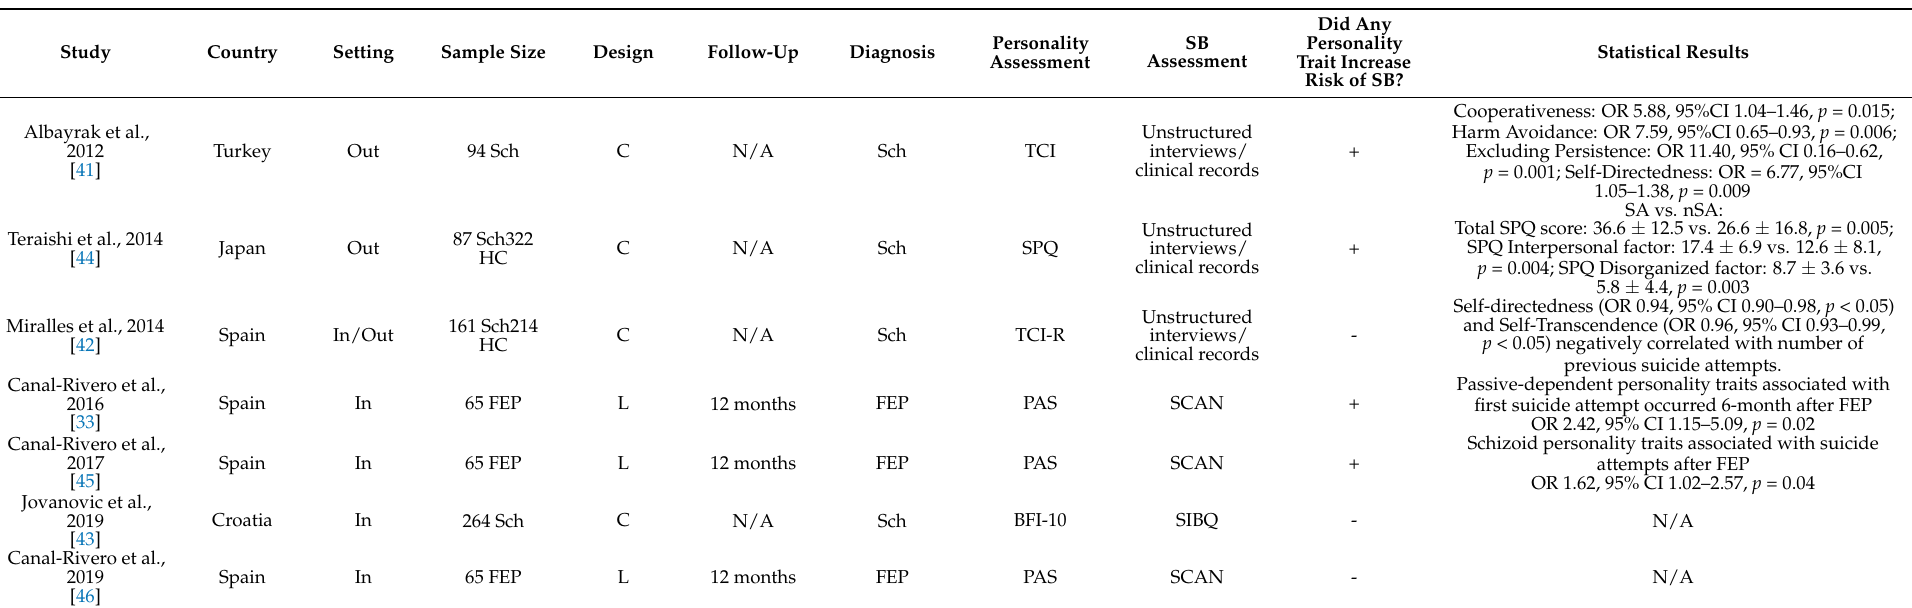
Table 1. Characteristics of the selected